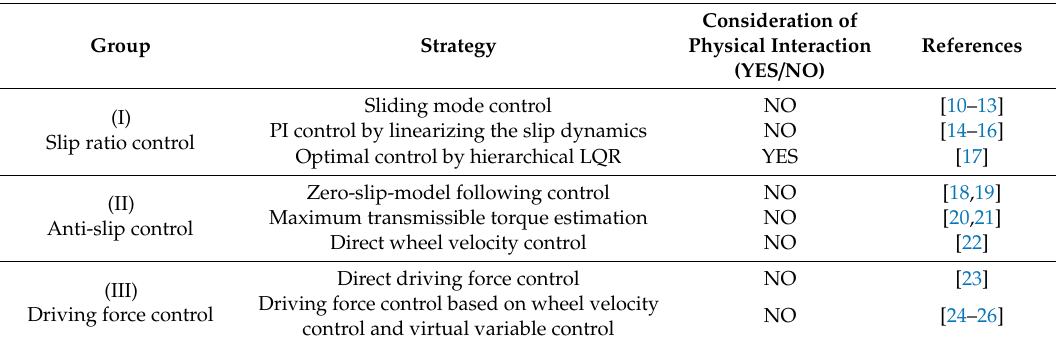
Table 1. Review of longitudinal motion control methods for